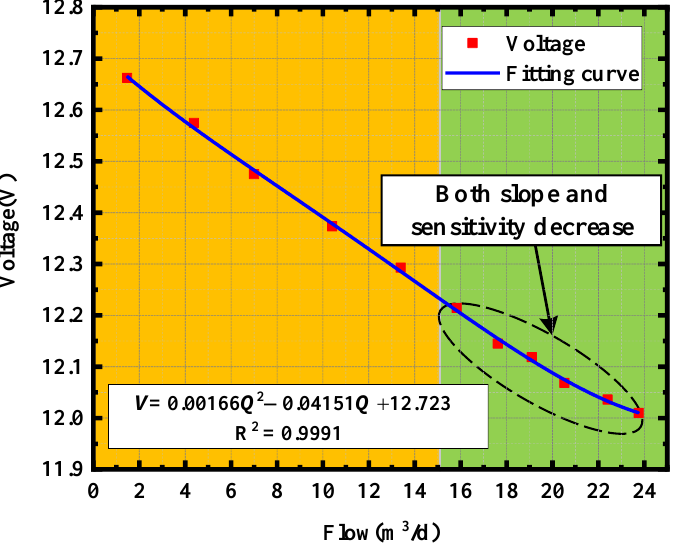
Figure 7. The non-linear relationship diagram of voltage with flow.